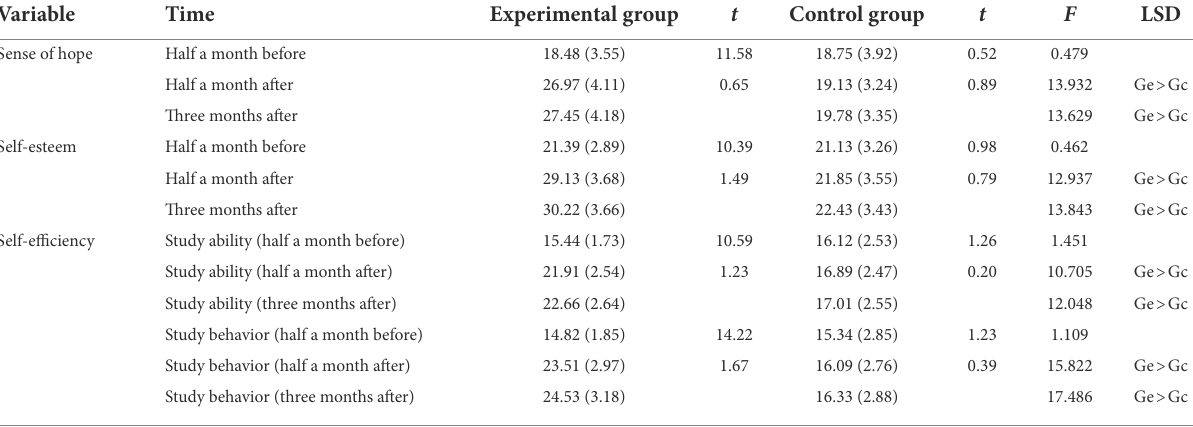
TABLE 2 The changes in hope, self-esteem, and self-efficiency of left-behind children (football group vs. table tennis). Variable Time